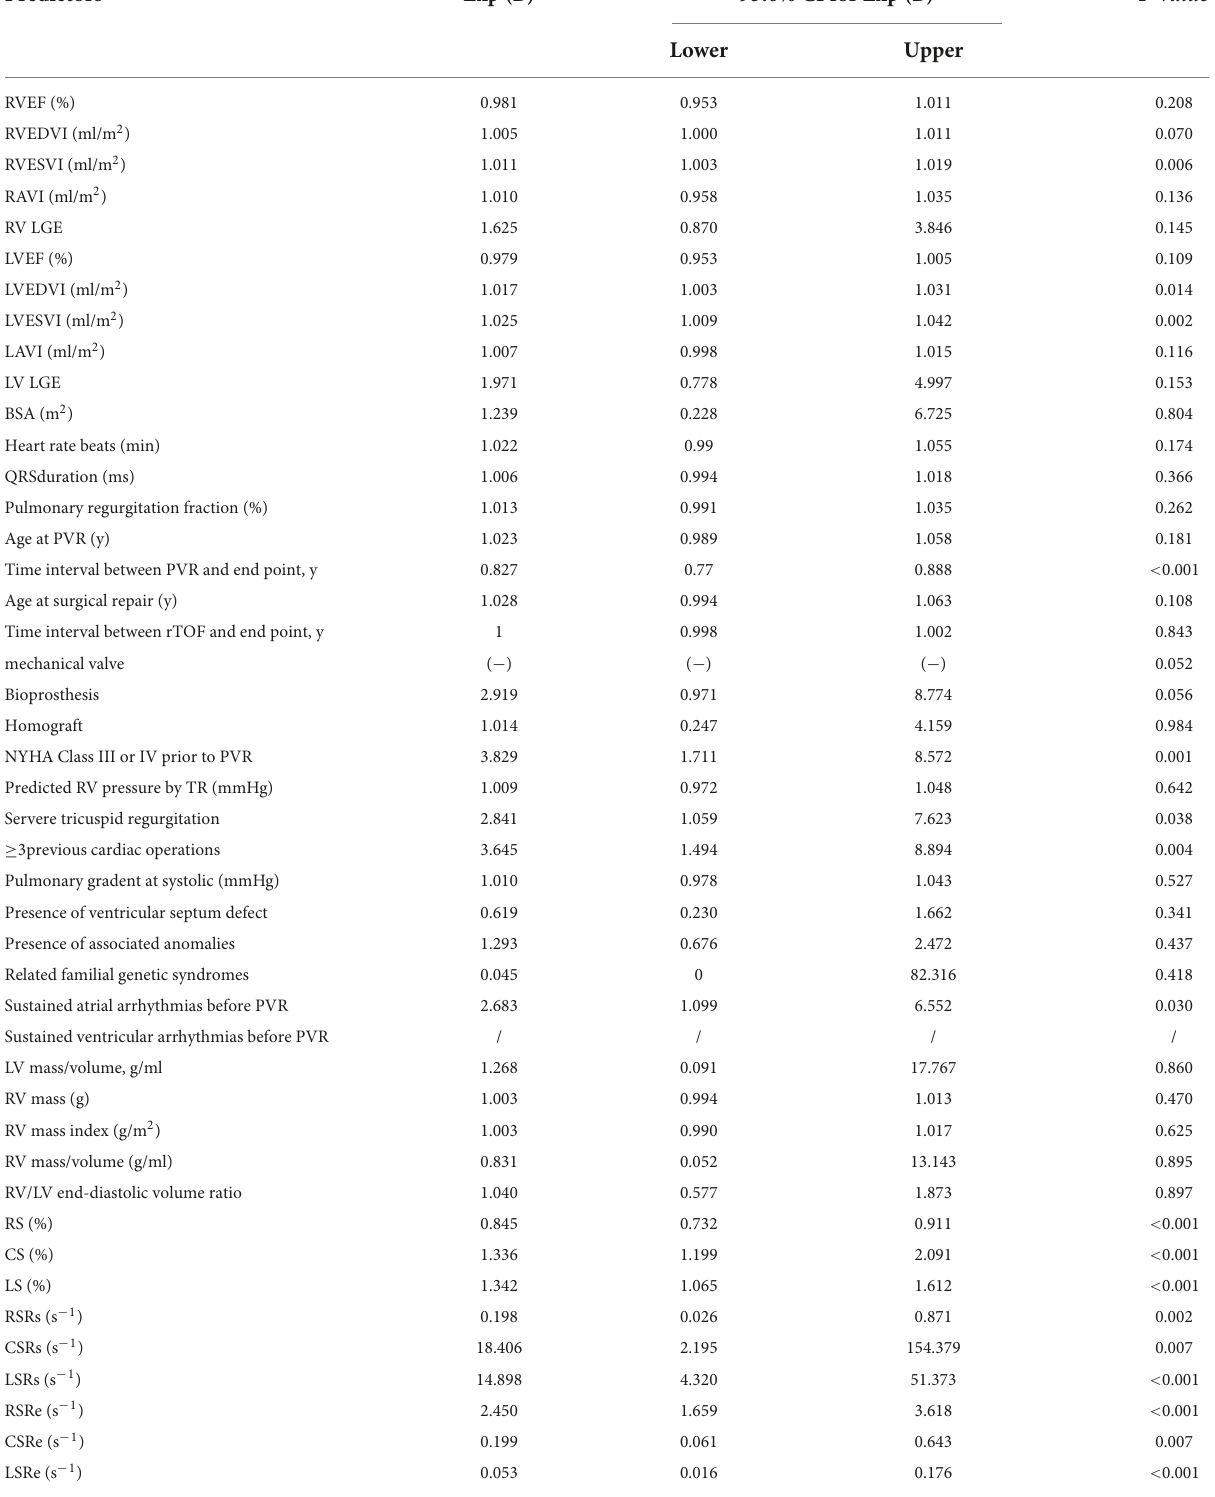
TABLE 4 Univariate associations of clinical and cardiac magnetic resonance (CMR) characteristics with adverse events.